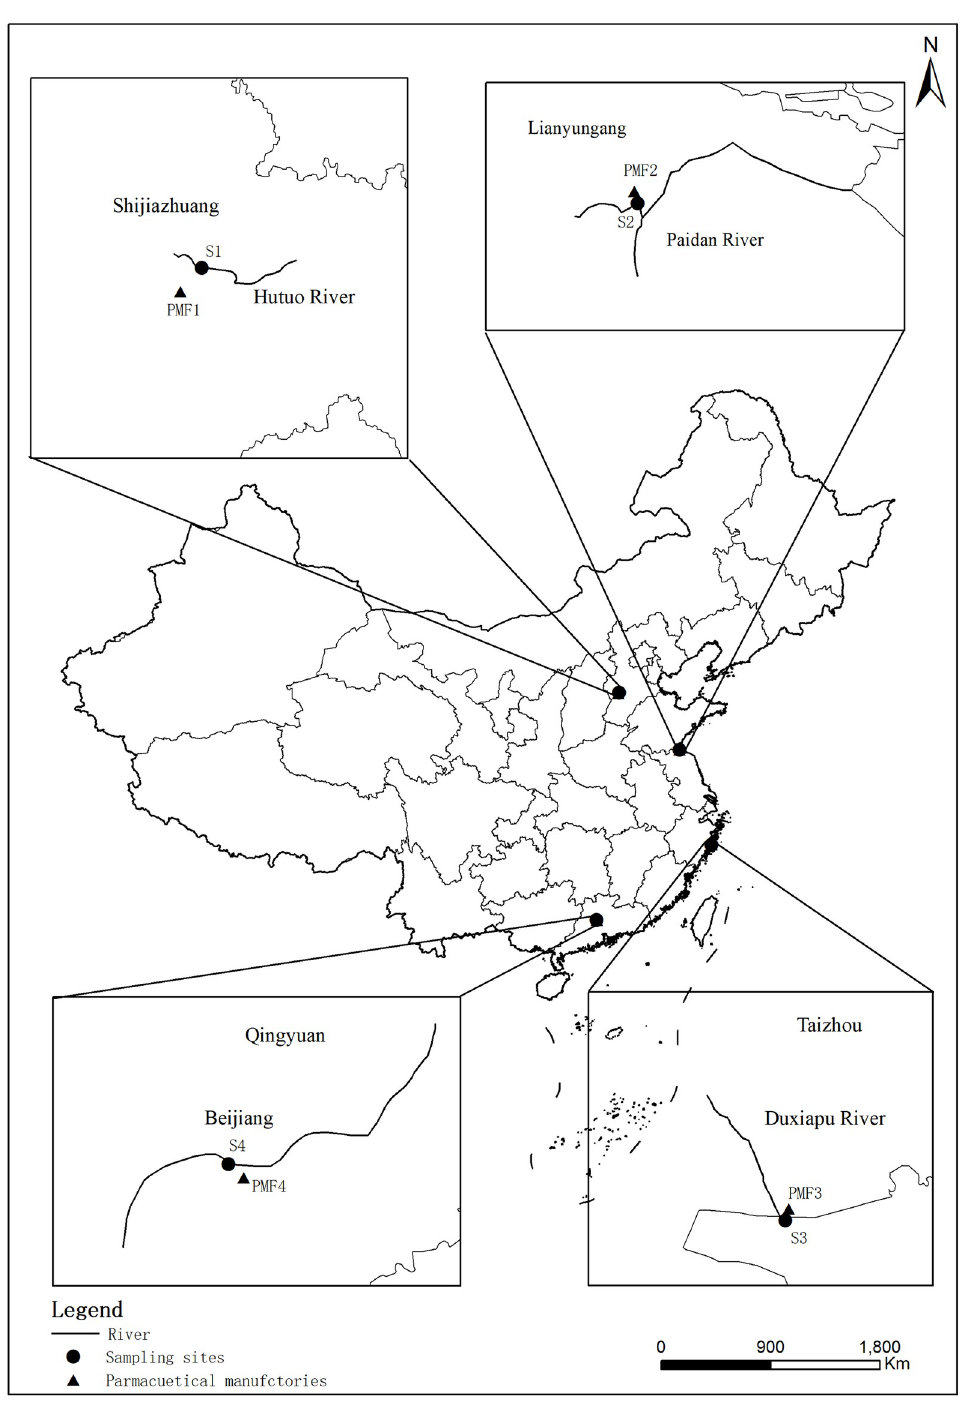
Fig 1. Sampling locations of the four PMFs (PMF 1 –PMF 4) and other sites in China.